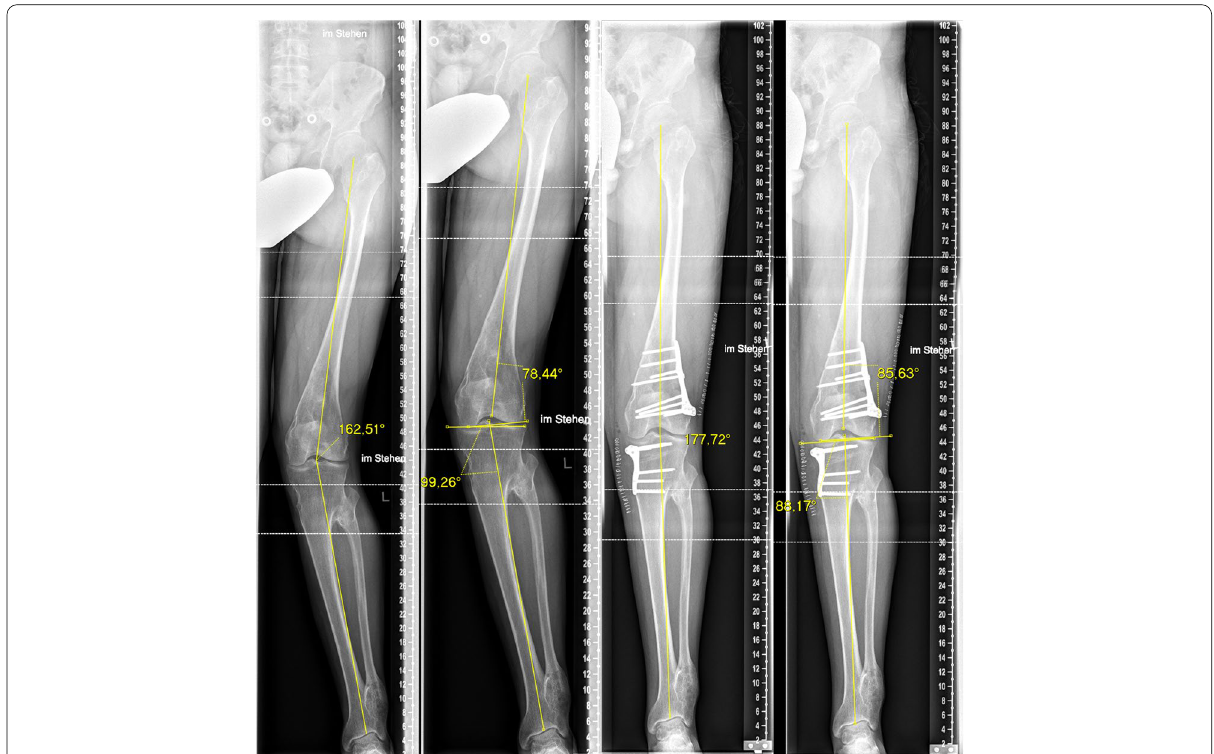
Fig. 5 The accuracy of the procedure was defined as the delta (∂) between planned correction and postoperative alignment measured on full weight bearing long leg radiographs (∂ HKA A